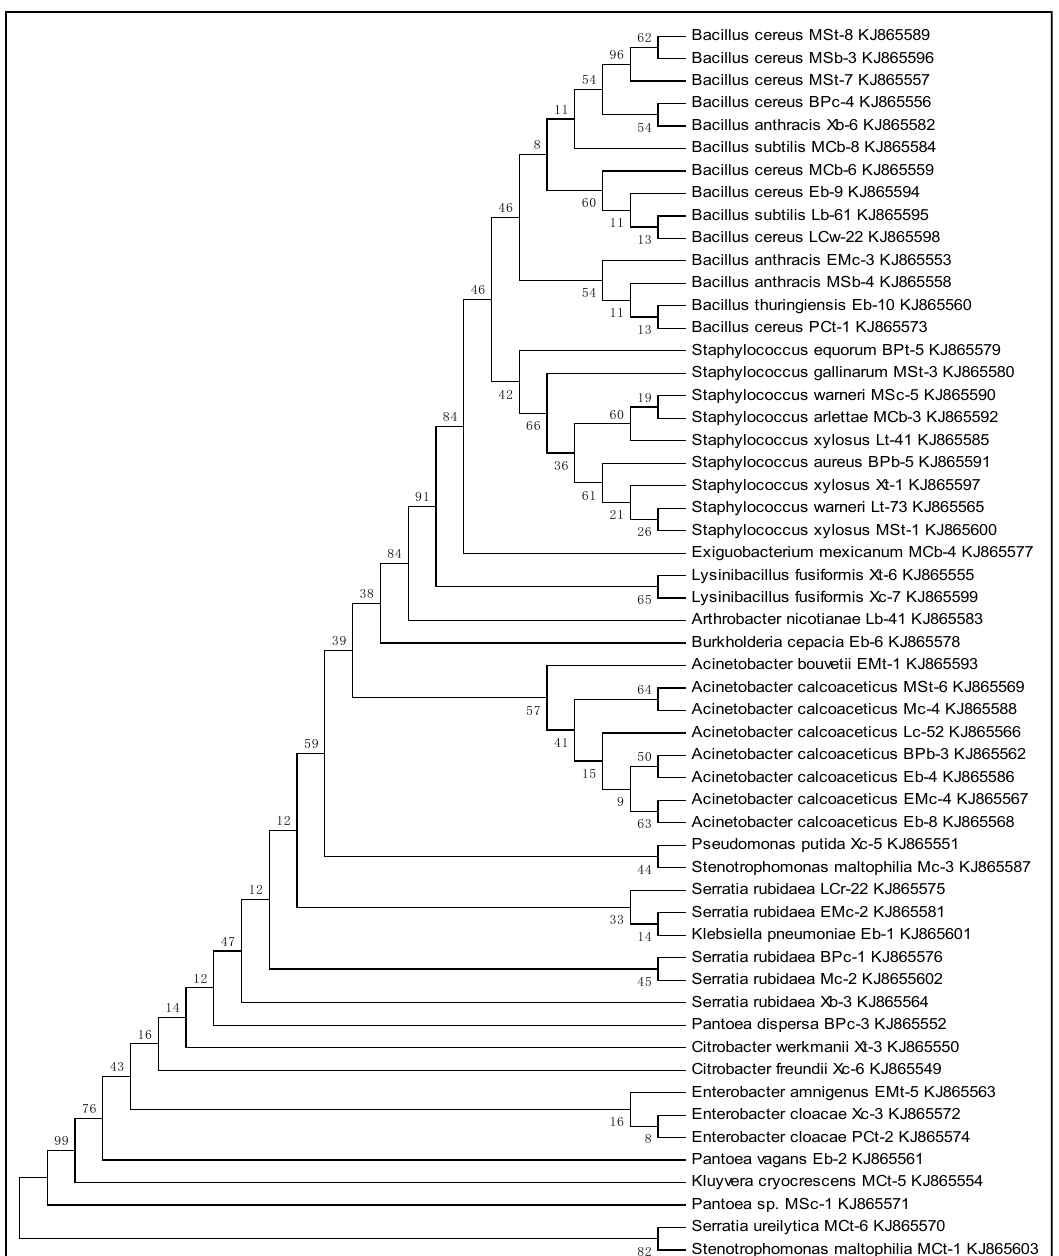
Figure 1. Phylogenetic analysis of 55 bacterial isolates associated with the surfaces of fresh vegetables (carrot, cabbage and turnip). Nucleotide sequences were trimmed after 16S rRNA gene sequencing. Phylogenies were inferred using the neighbor-joining method and the tree was constructed using MEGA 6 [24]. Numbers at the branch points indicate the percentage of 1000 bootstrap resampling.